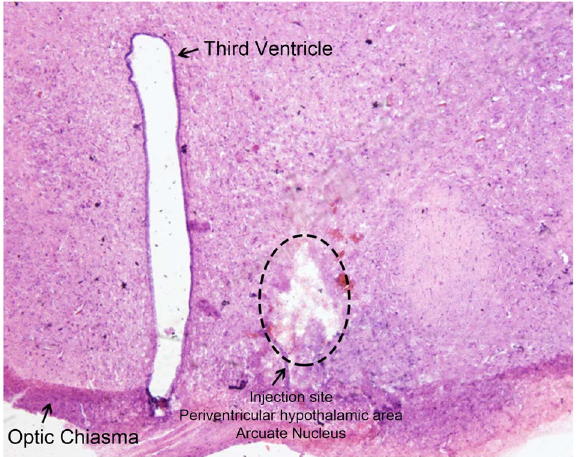
Figure 1. A sample anatomy slice with hematoxylin and eosin stain showing the location of the hypothalamic arcuate nucleus (ARC). A coronal section of hypothalamic regions showing the arcuate nucleus (ARC) (100 6